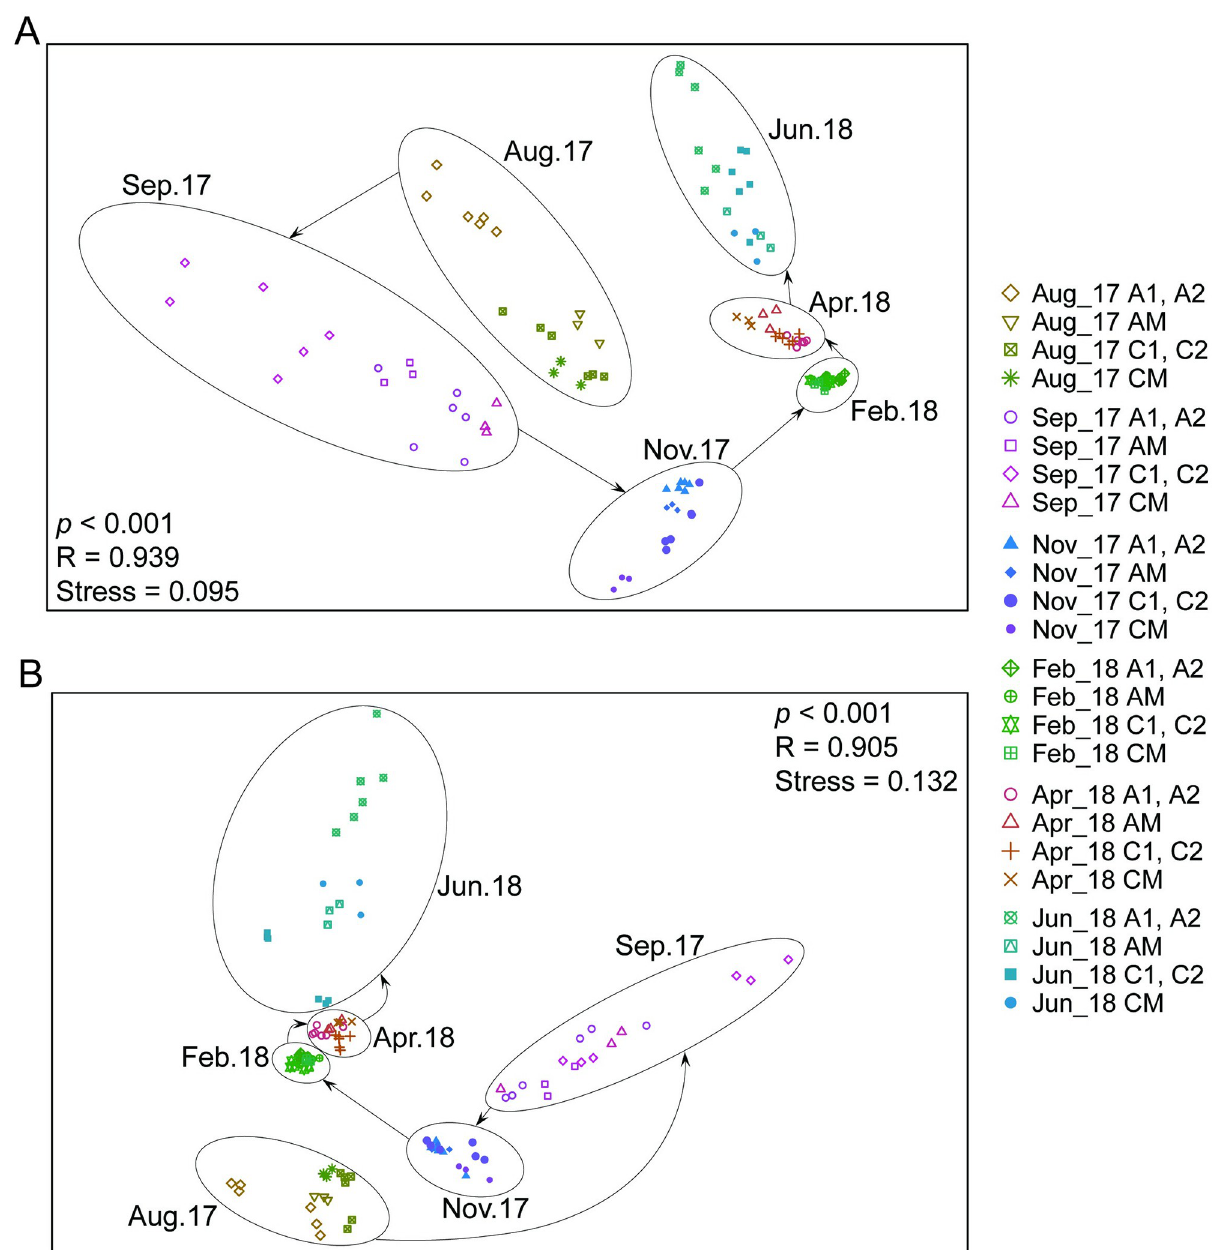
Fig 4. Two-dimensional nMDS ordination plots of planktonic assemblages in (A) surface and (B) bottom waters over the study period. Treatments are canal locations, with aeration canal (A1, A2), control canal (C1, C2) and Grand canal (CM, AM) in different months. The p and R values displayed in the figure were ANOSIM test